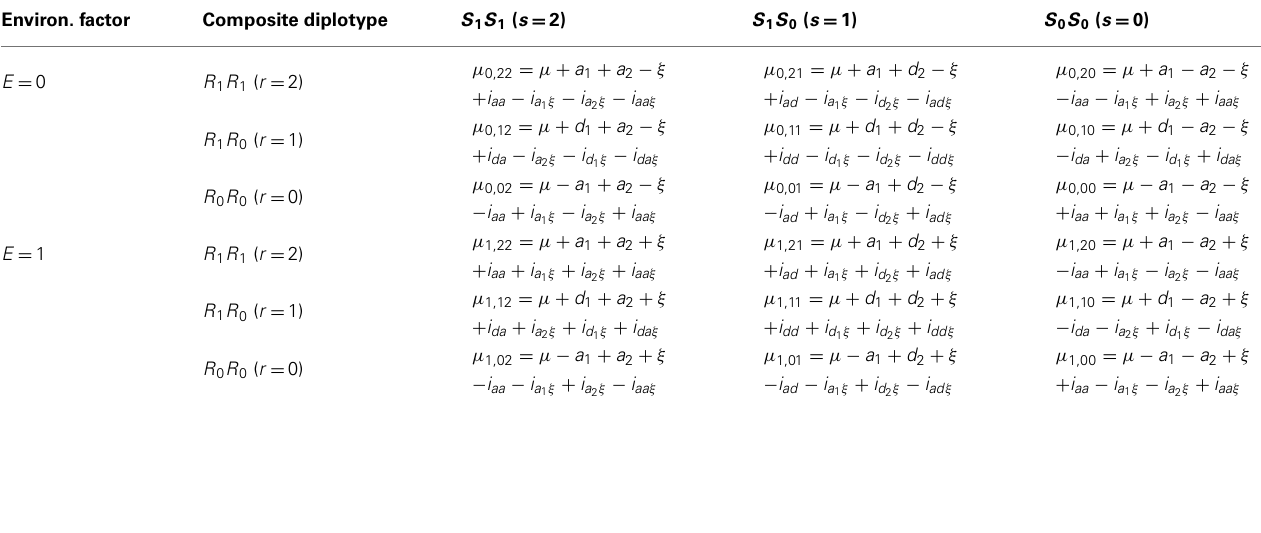
TableA2 |The genotypic values of 9 across-block composite diplotypes stratified by a binary environmental factor ( E = 0, 1). Environ.